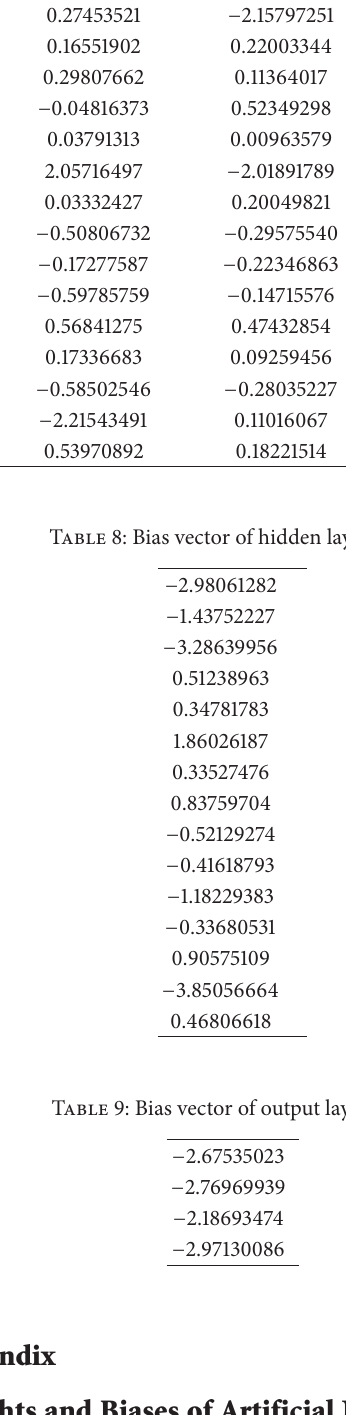
Table 6: Weight matrix of hidden layer (𝑊 ℎ )